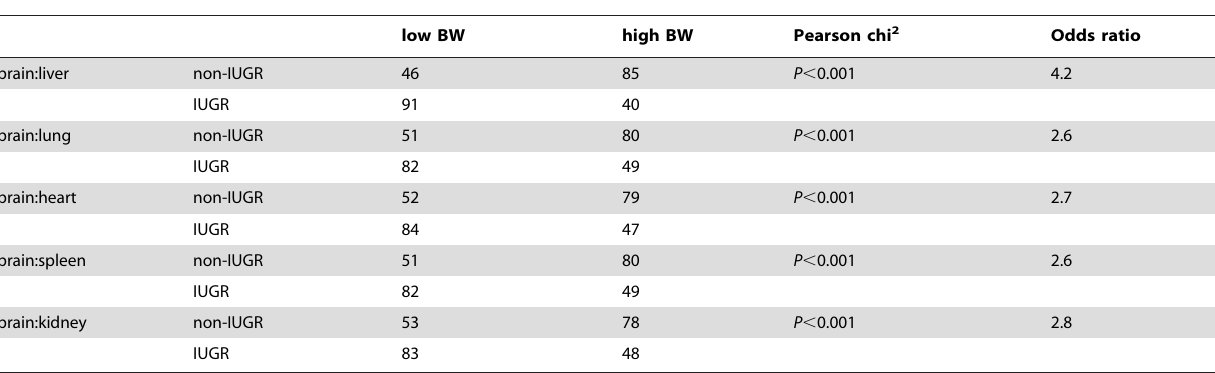
Table 3. Number of IUGR fetuses in low and high BW gilts.